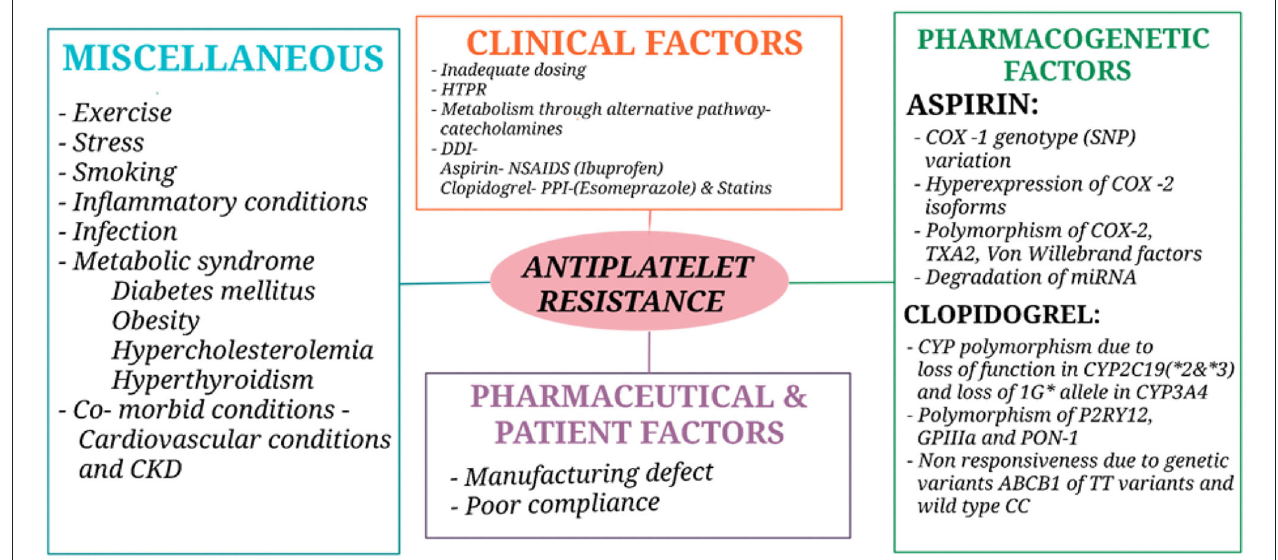
FIGURE 1 | Causes of antiplatelet resistance. CKD, Chronic kidney disease; HTPR, High on-treatment platelet reactivity; DDI, Drug drug interaction; NSAIDS, Non-steroidal anti-inflammatory drugs; PPI, Proton pump inhibitors; COX, Cyclooxygenase; TXA2, Thromboxane A2; miRNA, micro Ribonucleic acid; CYP, Cytochrome; GP, Glycoprotein; PON-1, Paraoxonase